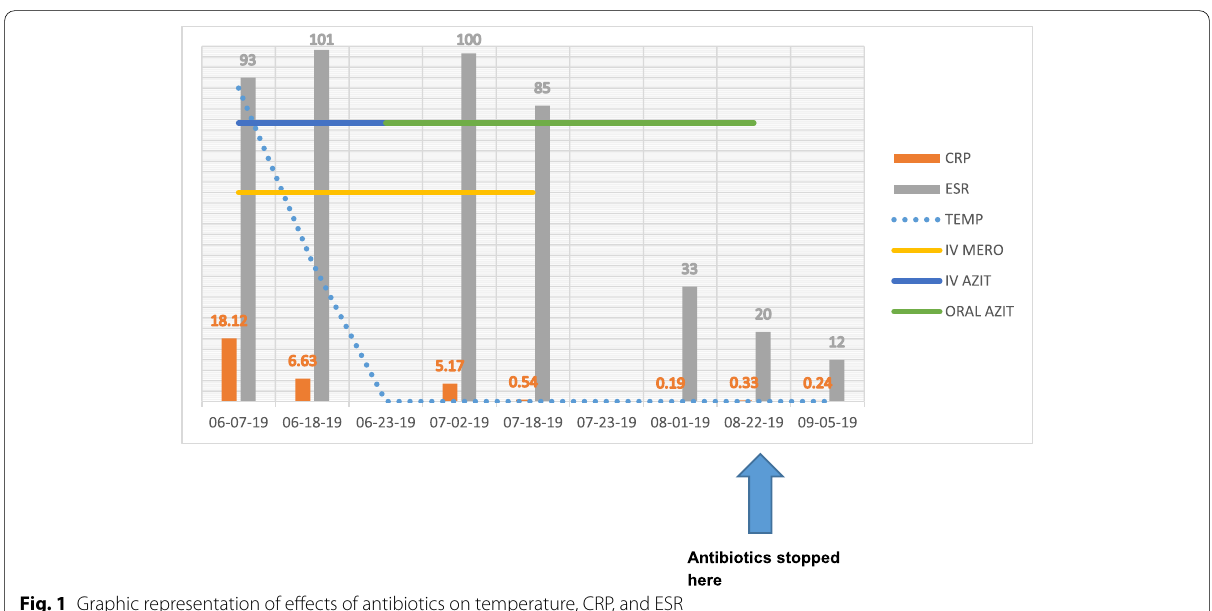
Fig. 1 Graphic representation of effects of antibiotics on temperature, CRP, and